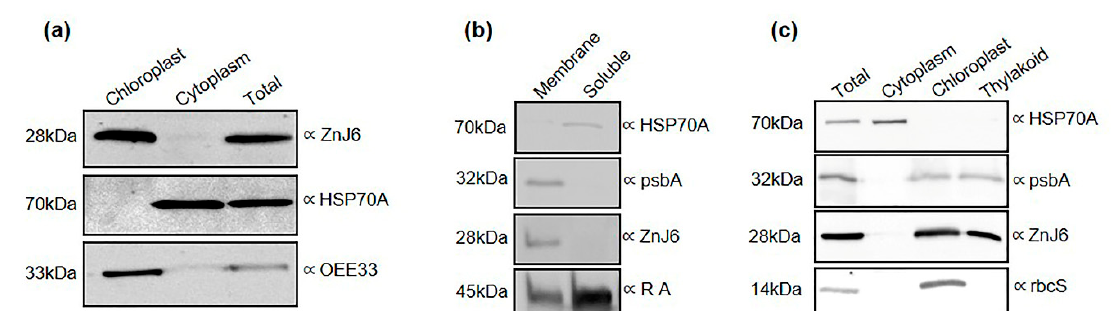
Figure 1. ZnJ6 is localized in the thylakoid membrane of the chloroplast. C. reinhardtii cells were grown until the late log phase and disrupted by nitrogen cavitation, and further subfractionated. ( a ) The purified chloroplasts, cytoplasm, and total proteins were subjected to western analysis using antibodies against oxygen-evolving enzyme (OEE33) as a chloroplast marker and HSP70A as a cytoplasmic marker; ( b ) The membrane and soluble fractions of C. reinhardtii cells were separated, and the presence of ZnJ6 in the membrane fraction was confirmed. Antibody against psbA served as a membrane marker, HSP70A for the soluble protein fraction, and Rubisco Activase (RA) is a marker for proteins in both the membrane and soluble fractions; ( c ) Thylakoid membranes were isolated using a sucrose step gradient. Samples taken from the total extracts, cytoplasm, chloroplast, and thylakoid fractions were subjected to western analysis using antibodies against psbA as a thylakoid marker, rbcS as a chloroplast marker, and HSP70A as a cytoplasmic marker. ZnJ6-specific antibodies indicated their presence in the thylakoid membrane. Equal protein loads for each fraction were determined by the bicinchoninic acid (BCA) protein assay (Ponceau staining is shown in the original blots in the supplemental data).